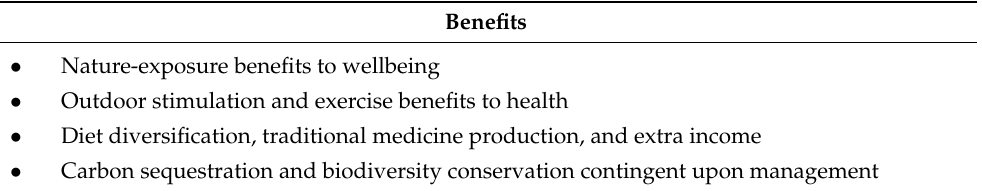
Table 3. Contribution of home gardening to sustainable development